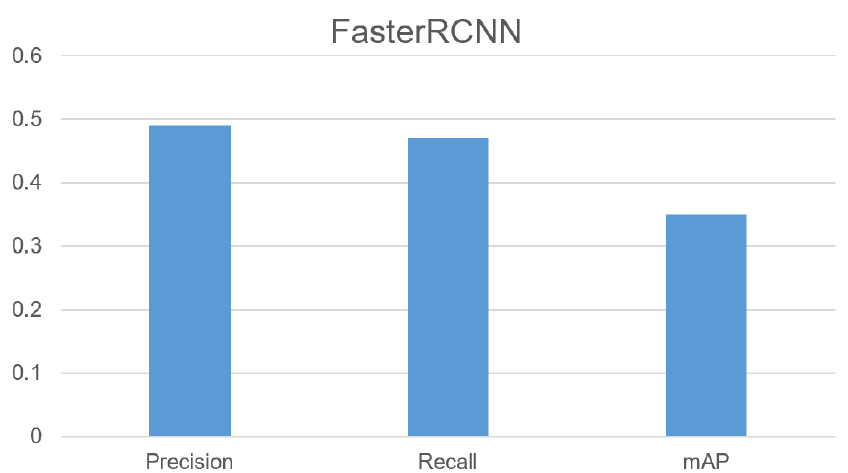
Figure 13. FasterRCNN visual representation.